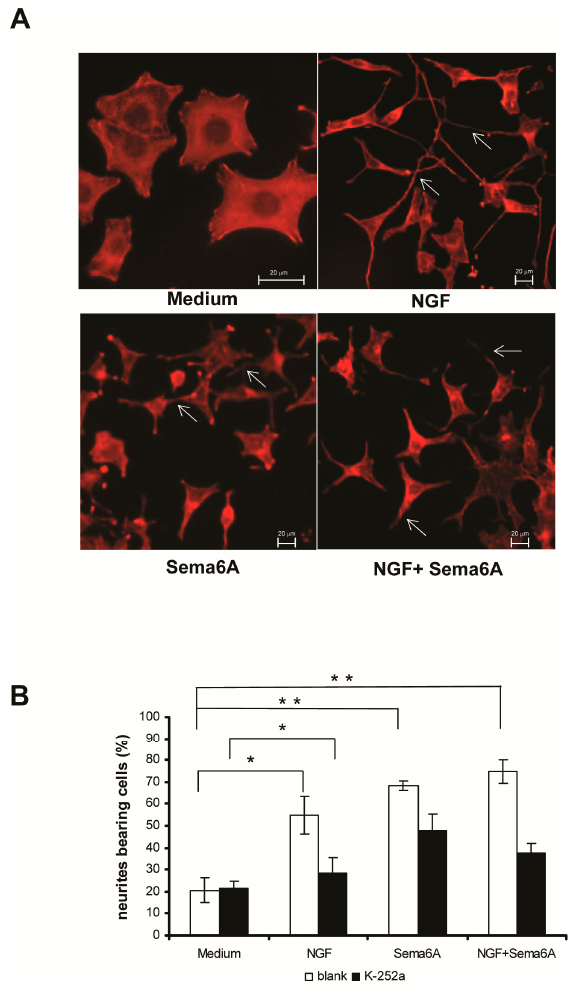
Figure 1. Semaphorin 6A (Sema6A) induced neurite outgrowth in PC12 cells. ( A ) PC12 cells were cultured in RPMI-1640 containing 50 ng/mL NGF and/or 1 nM Sema6A for 24 h and then the cell cytoskeleton stained with Alexa Fluor ® 594 phalloidin (ThermoFisher Scientific, Waltham, MA, USA). PC12 cells cultured in normal RPMI-1640 medium were used as controls. Arrows indicate the represented cells with neuritis; ( B ) PC12 cells were pretreated with 100 nM K-252a for 30 min. Next, 50 ng/mL nerve growth factor (NGF) and/or 1 nM Sema6A were added to the medium, cells incubated for another 24 h and the cytoskeleton stained with Alexa Fluor ® 594 phalloidin. Neurite outgrowth was quantified by counting PC12 cells bearing at least one neurite with a length longer than twice the cell body diameter. Each value is the mean ± standard error (S.E.) for >100 PC12 cells from three independent experiments. (* p < 0.05, ** p < 0.01).